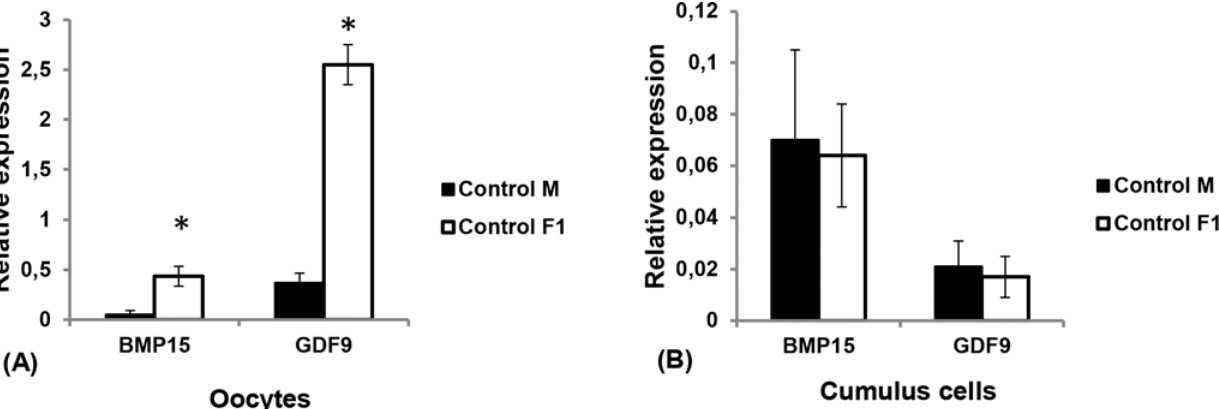
Fig 1. mRNA level of GDF9 and BMP15 in the oocytes (A) and cumulus cells (B) of the female rabbits in dependence on age. The results were obtained by comparison of the control groups from both generations – does-mothers and F1 female offspring. Total RNA was extracted from the oocytes and cumulus cells and subjected to real-time PCR to determine the mRNA levels of BMP15 and GDF9. The expression of these mRNAs was normalized to the expression of control gene GAPDH. The triplicates for each reaction were averaged. This data represent the mean ± SEM of the combined results from the analysis of seven rabbits from each group ( * , P < 0.05). The significantly higher expression of BMP15 and GDF9 in the oocytes from the ovaries of F1 female compared to the mothers' generation was